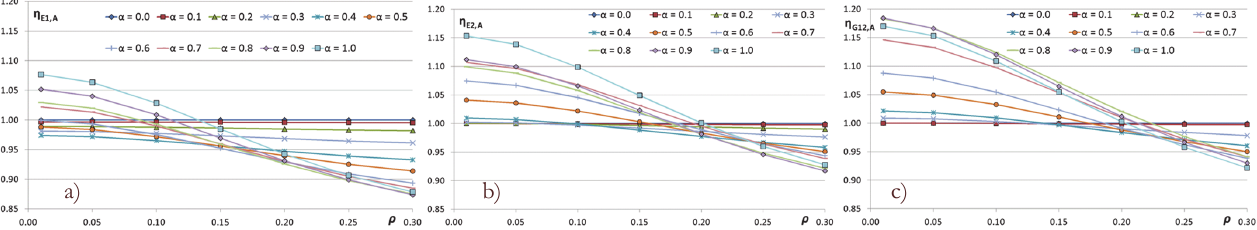
Figure 19: Correction factors vs. relative density for different values of the irregularity parameter: a)  E1,A ; b)  E2,A ; c)  G12,A